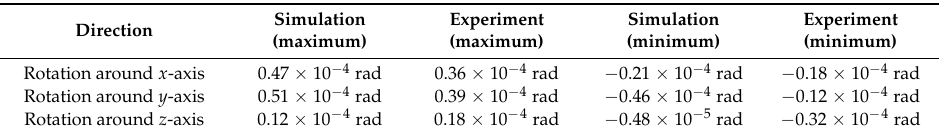
Table 4. Comparison of the kinematic results between the simulation and experiment.